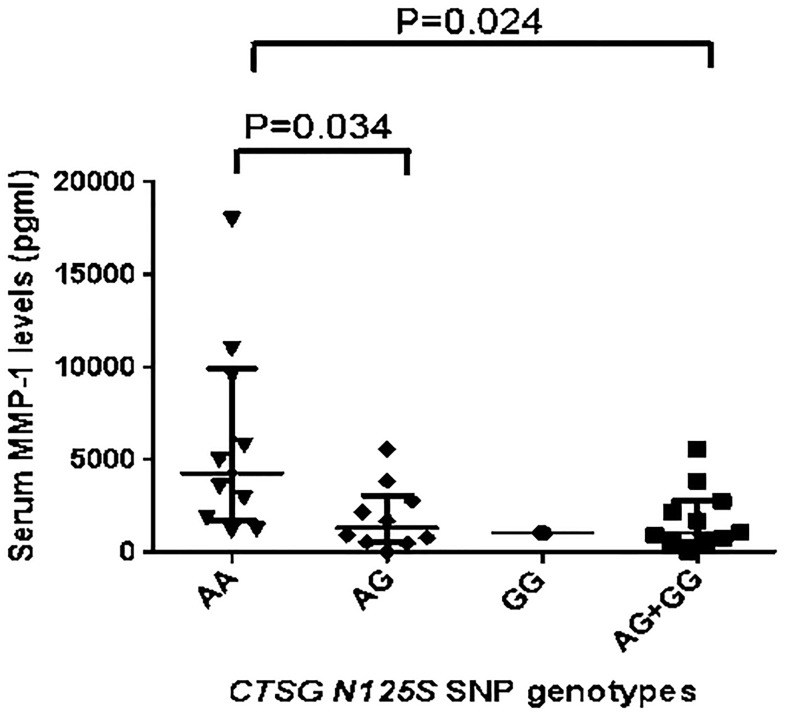
Serum MMP-1 levels in carriers of the different genotypes of the CTSG (rs 45567233).Serum MMP-1 levels from 27 patients with acute osteomyelitis were determined after the end of treatment by ELISA and the group was divided according to whether or not they carried the G allele. Individual patients’ results are shown and the median and IQR. There were 10 carriers of the AA, 10 of the AG and 1 of the GG genotypes of the CTSG N125S (rs 45567233) polymorphism.